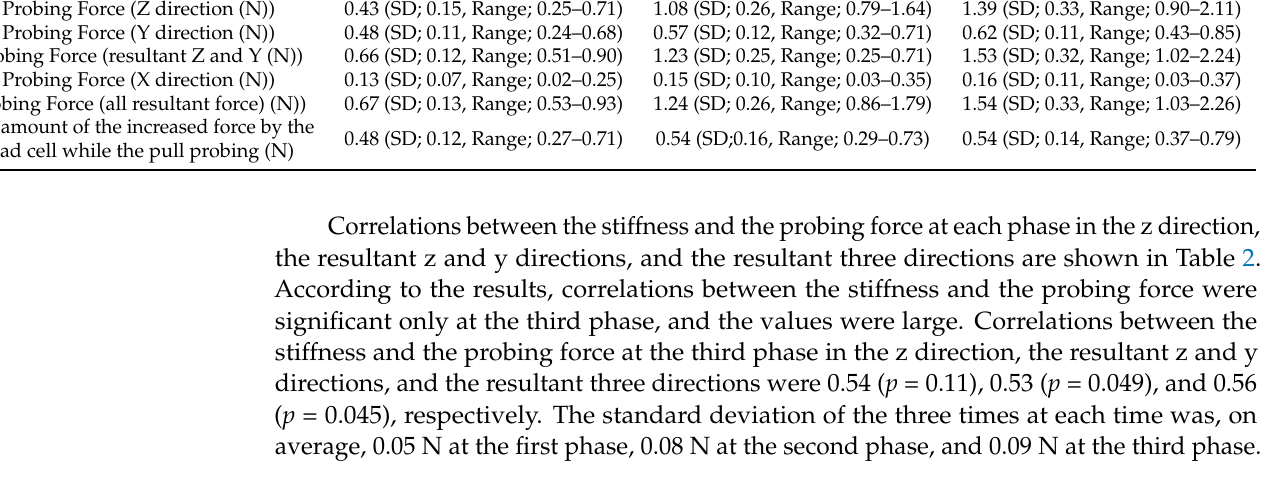
Table 2. The correlation between stiffness and Young’s modulus by the tensile tester, and the probing force by the probing